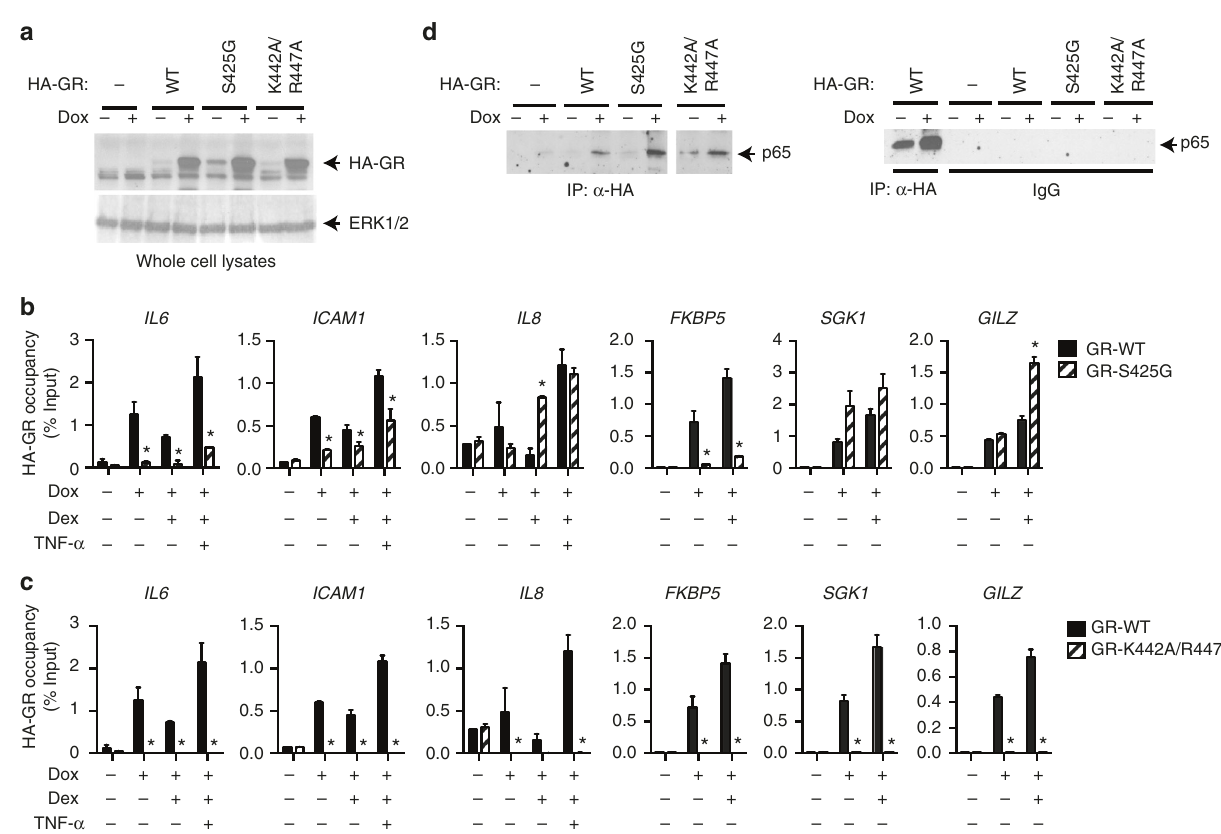
Fig. 1 DNA-binding domain mutations alter recruitment of GR to native target genes. a – c HEK293T cells were transfected with the indicated expression plasmids. The next day, the cells were steroid-deprived and treated with or without 1 μ g/ml doxycycline (Dox) for 24 h. a Whole cell lysates were analyzed by western blotting using anti-HA and anti-ERK1/2 antibodies. Uncropped blots are shown in Supplementary Figure 7. b , c HEK293T cells stimulated for 1 h with 100 nM dexamethasone (Dex) alone or in combination with 10 ng/ml TNF- α as indicated and analyzed by ChIP assay using anti-HA antibody. Shown as fold enrichment relative to vehicle (mean + SEM, n = 3) *Dunnett ’ s multiple comparisons test, p adj < 0.05 relative to GR-WT transfectants. d HEK293T cells were transfected with p65/RelA, rtTA, and the inducible HA-GR- WT or -mutant expression plasmids. The next day, the cells were steroid-deprived and treated with or without 1 μ g/ml Dox for 24 h and then stimulated with 10 ng/ml TNF- α for 1 h. Whole cell lysates were analyzed by IP using anti-HA antibody or normal (pre-immune) rabbit IgG, followed by western blotting using anti-p65